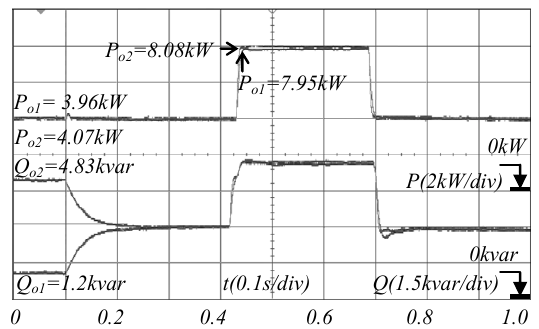
Figure 12. The experimental active/reactive power of proposed method in experiment I.